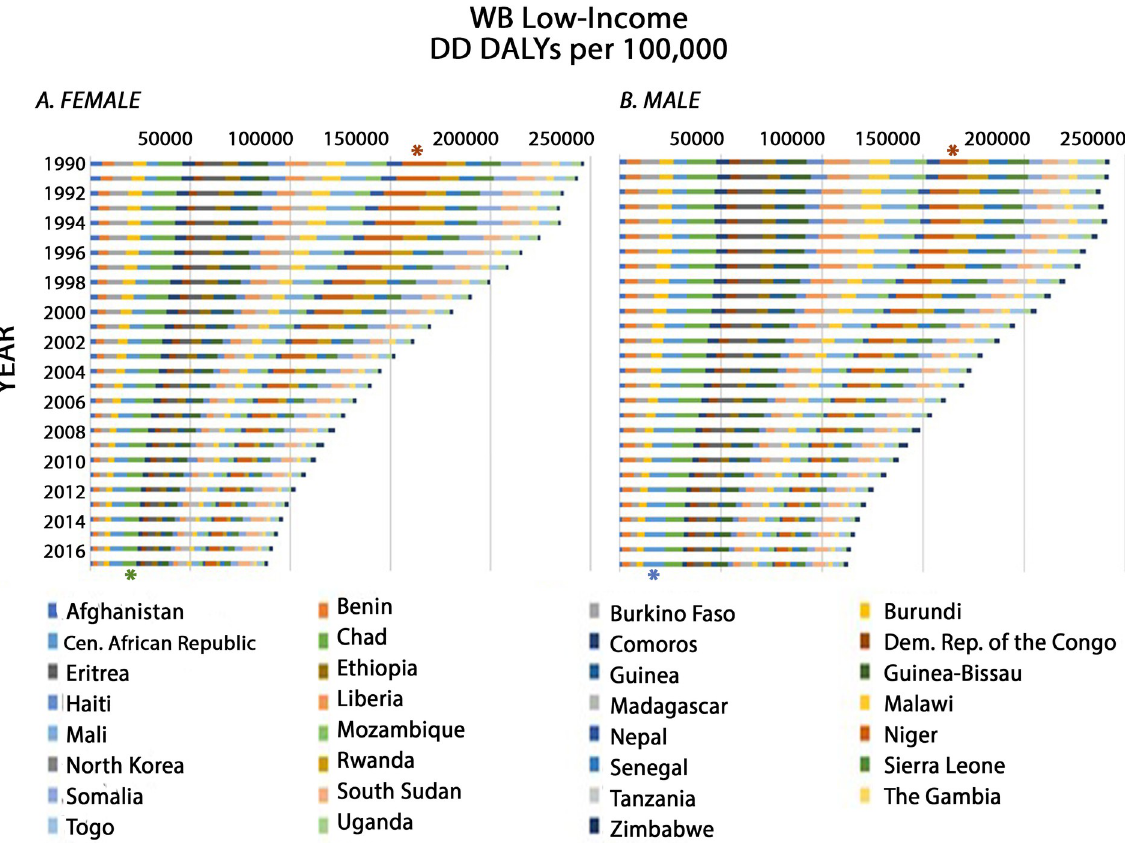
Fig 6. Age-standardized DD DALY rates from 1990 to 2017 in WB low-income constituents for females (A) and males (B). For each year (bar), the DD DALY rate per 100,000 represents the sum of individual country DD DALY rates given in alphabetical order from left to right as follows: Afghanistan, Benin, Burkina Faso, Burundi, Central (Cen.) African Republic, Chad, Comoros, Democratic (Dem.) Republic (Rep.) of Congo, Eritrea, Ethiopia, Guinea, Guinea-Bissau, Haiti, Liberia, Madagascar, Malawi, Mali, Mozambique, Nepal, Niger, North Korea, Rwanda, Senegal, Sierra Leone, Somalia, South Sudan, Tanzania, Togo, The Gambia, Uganda and Zimbabwe. Brown asterisks identify data from Niger, which had the highest number of DD DALYs per 100,000 for both females (value = 21,842.85 (95% UI: 14,124.44566–29,316.44)) and males (value = 13,595.21 (95% UI: 8,862.79–19,531.25) in 1990. The blue asterisk identifies data from Central African Republic, which had the highest number of DD DALYs per 100,000 for males (value = 10,497.14 (95% UI: 5,794.68–16,518.80)) and the green asterisk identifies Chad, which had the highest number of DD DALYs per 100,000 for females (value = 6,963.74 (95% UI: 5,098.99–9,369.92)) in 2017.